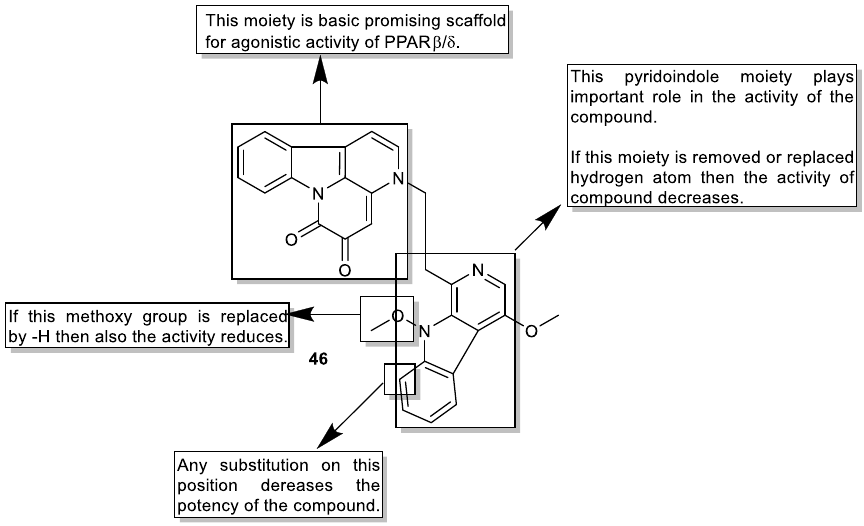
Figure 50. Structural activity relationship of picrasidine N hybrids ( 46 ) as potent PPAR ligands.